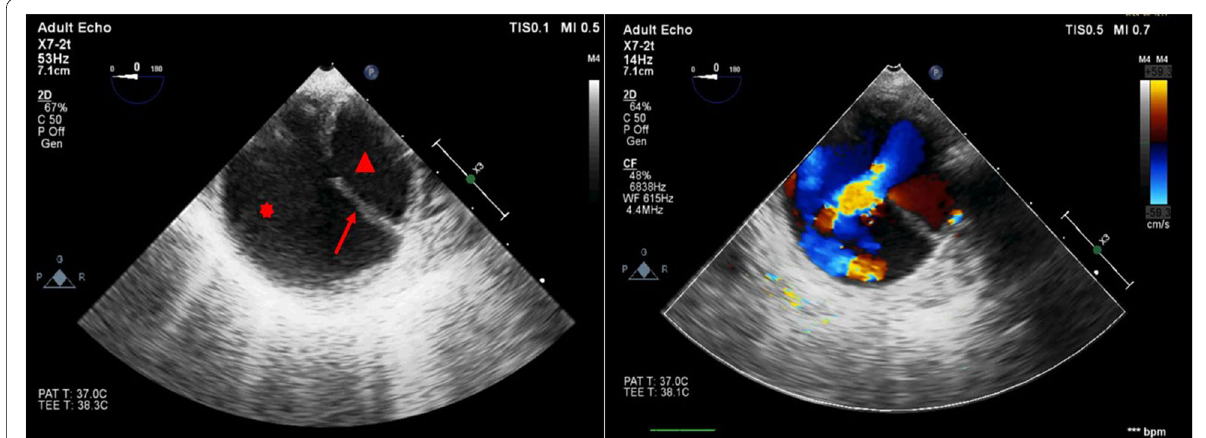
Fig. 2 Transesophageal echocardiography of the descending aorta in short axis. True lumen (red arrowhead) and false lumen (red asterix) are separated by an intimal flap of the dissected aorta, with an intimal tear (red arrow) at the level of the mid descending thoracic aorta (left) and color flow mapping confirming blood flow from true lumen to false lumen through the intimal tear (right)